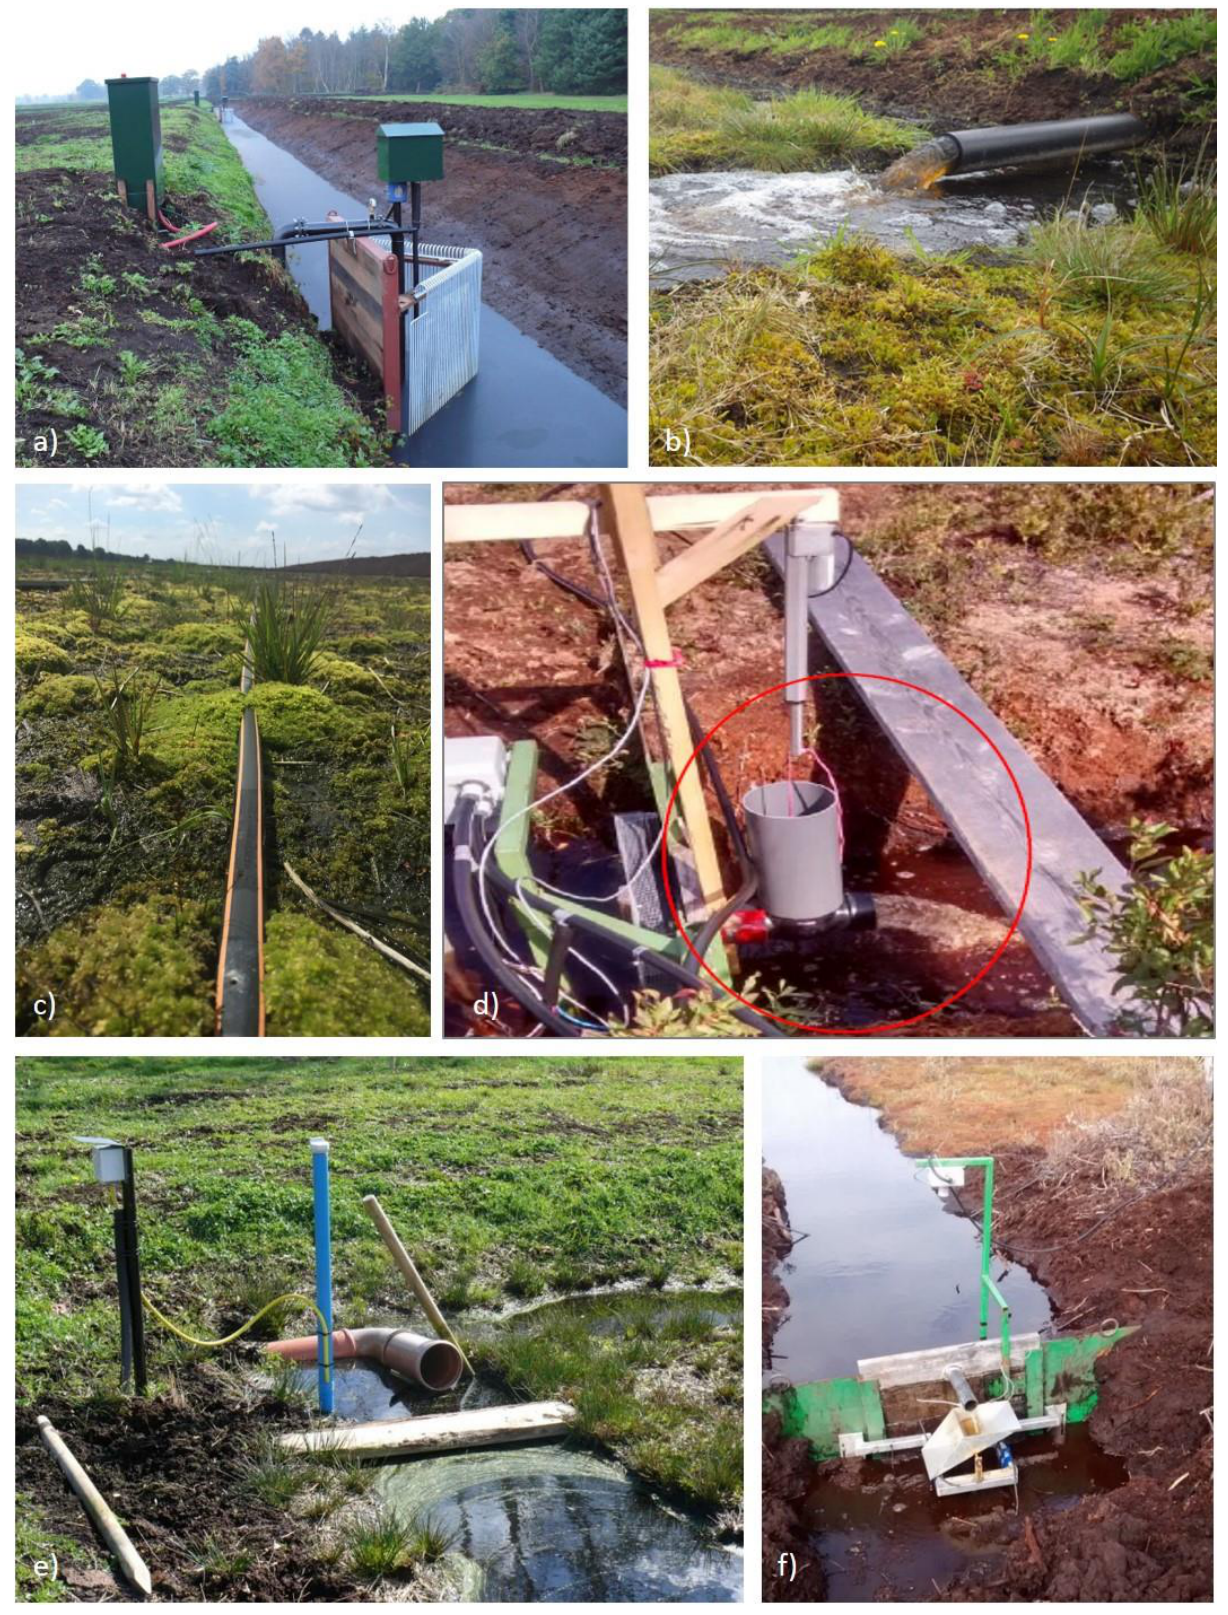
Figure 4. Water management components for Sphagnum farming sites: a) electric pump (Rastede); b) inlet into the irrigation ditches (Rastede); c) drip irrigation (Drenth); d) ‘adjustable ditch’ with an outlet (Shippagan 2); e) outlet with a data logger (Rastede); f) outlet (Saint-Modeste). Photos: a) and e) Sabine Wichmann, b) Greta Gaudig, c) Dorothea Rammes, d) and f) Peatland Ecology Research